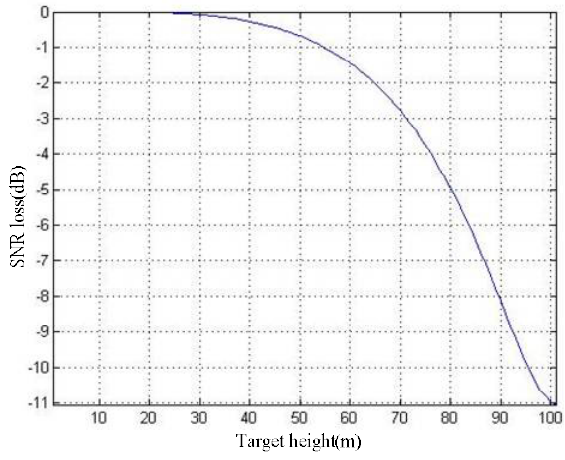
Figure 11. h–S loss curve.